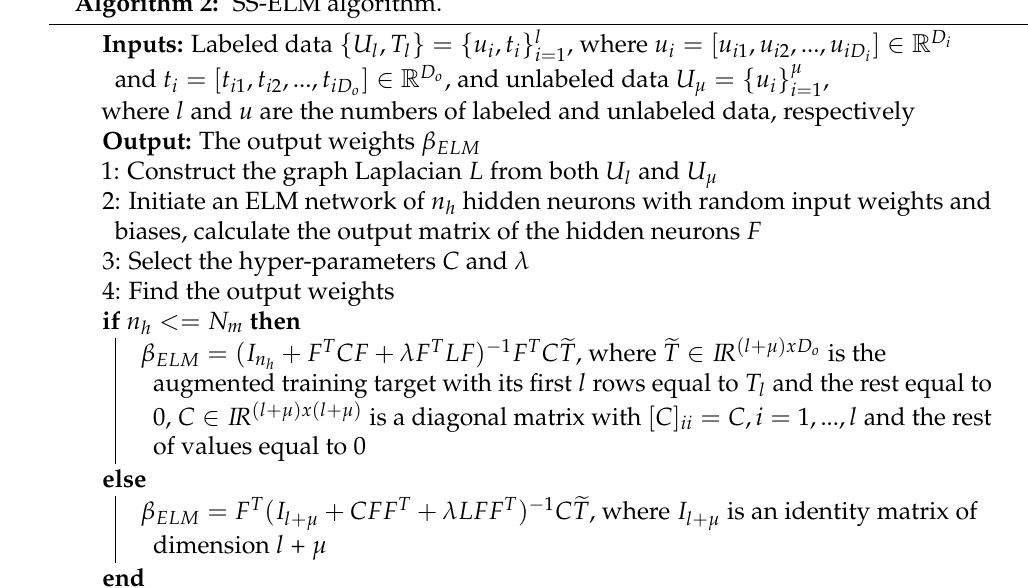
Algorithm 2: SS-ELM